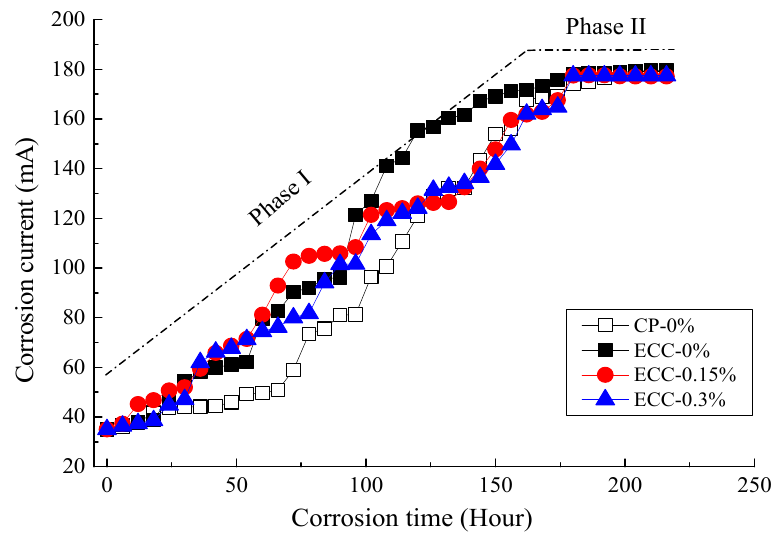
Figure 8. Impressed current versus exposure time for the CP and ECC grouts.